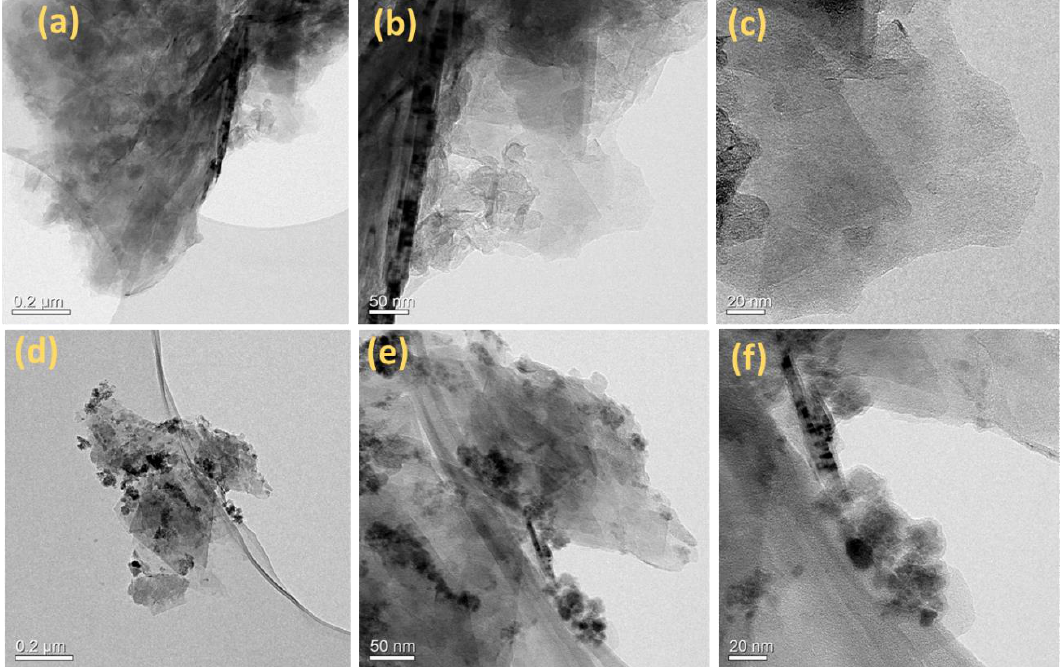
Figure 1. TEM images of GO ( a – c ) and CoO x - Fe 3 O 4 /N - rGO ( d – f ). Scale bars are 0.2 µm ( a , d ), 50 nm ( b , e ), and 20 nm ( c , f ). ( b , e ), and 20 nm ( c , f